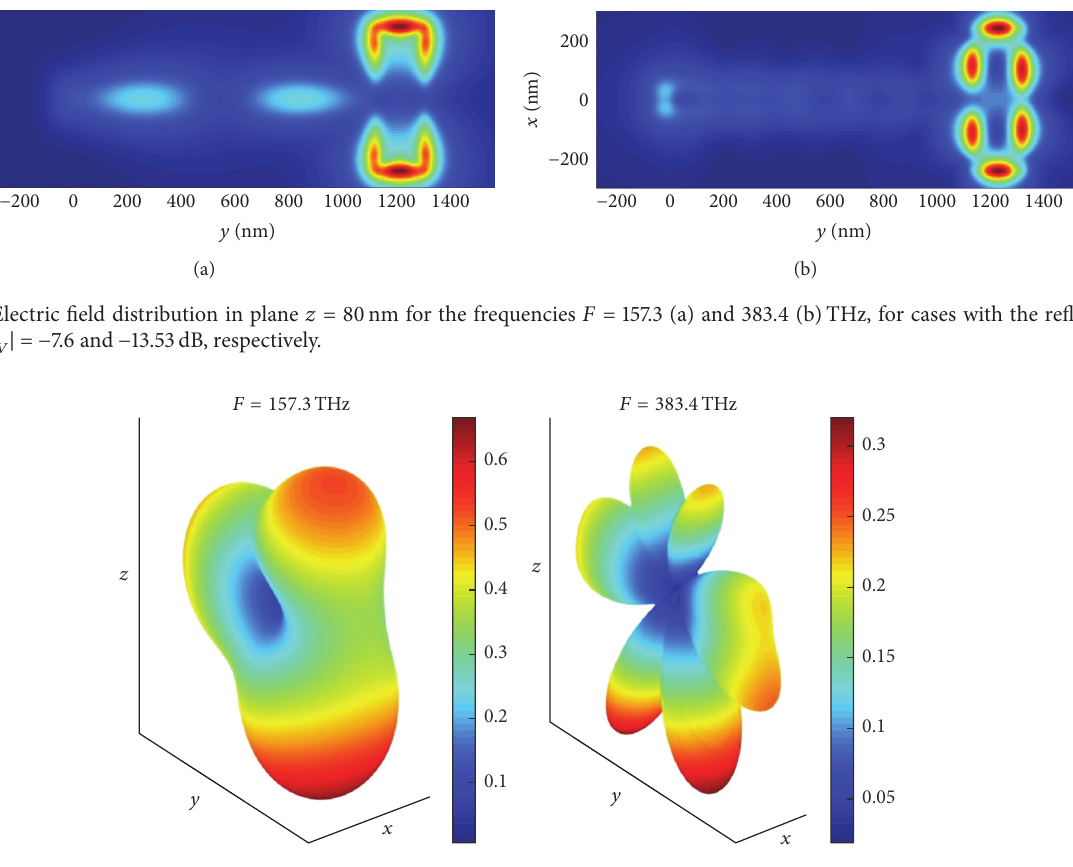
Figure 21: 3D far field gain radiation pattern of the circuit for 𝐹 = 157.3 and 383.4 THz.